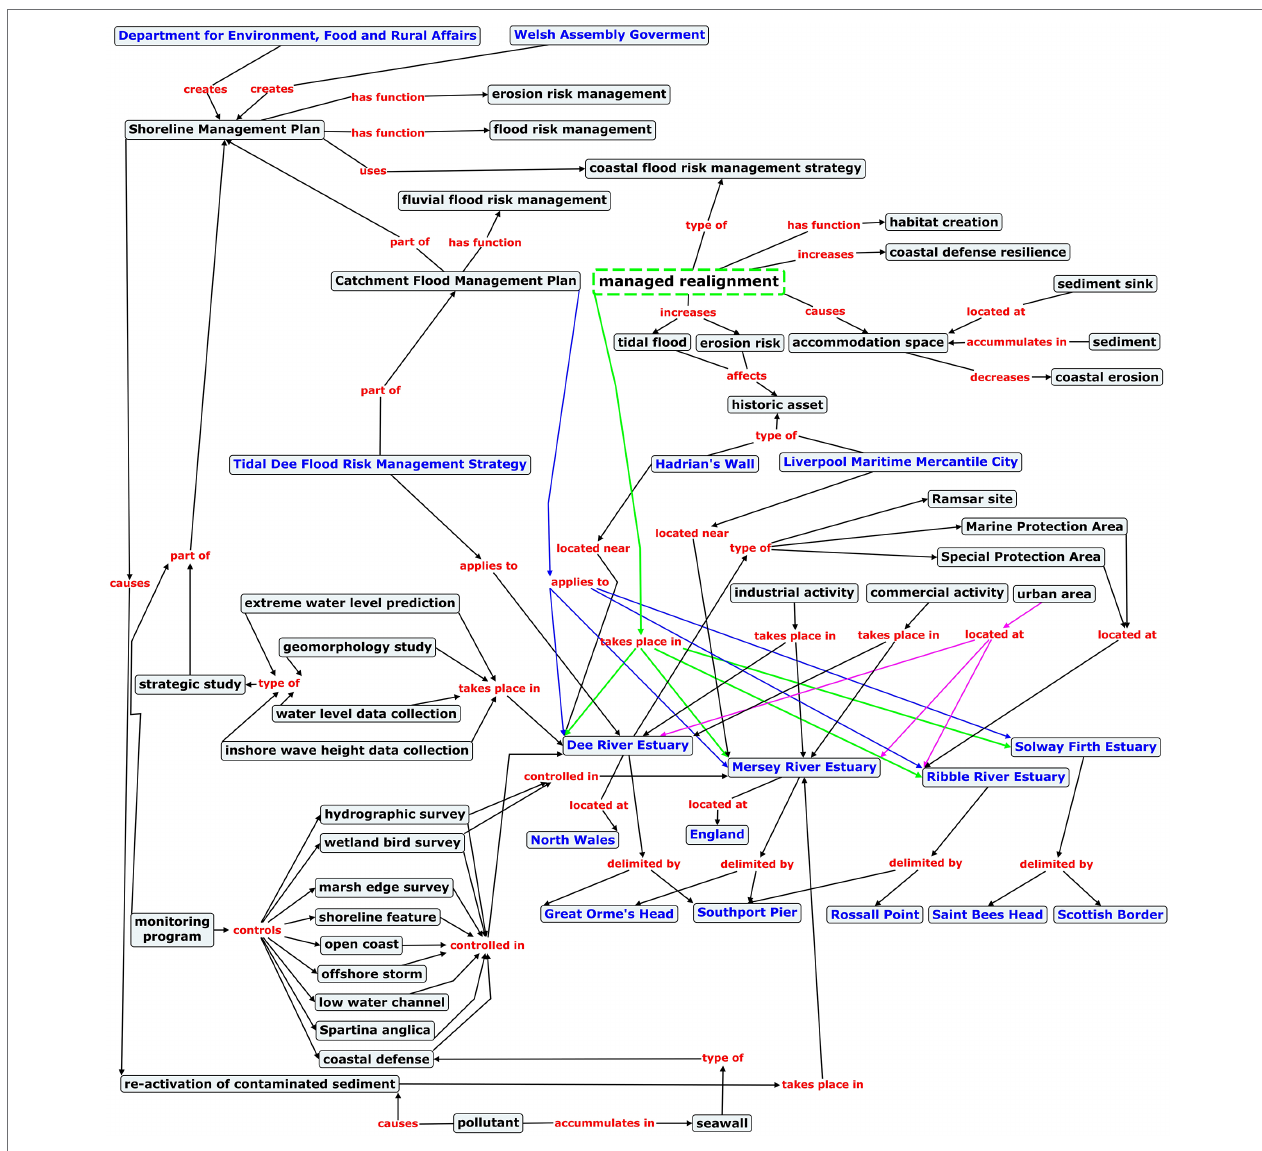
FIGURE 4 | Semantic network evoked by the Dee, Mersey, Ribble, and Solway Firth estuaries, which also serves as the geographic contextualization of the managed realignment concept in the Coastal Engineering